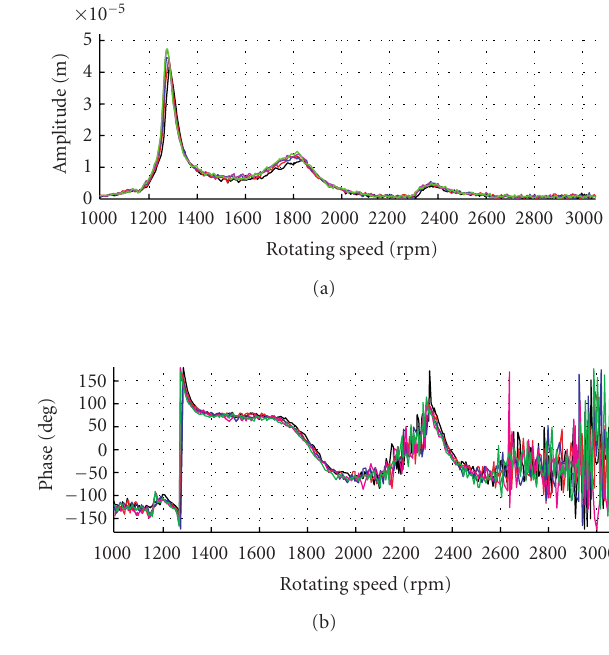
Figure 15: Unbalance responses of the 1st order during run-down for various bearing temperatures at the bearing support B1 (black line = 33 ◦ C; red line = 36 ◦ C; blue line = 40 ◦ C; magenta line = 42 ◦ C; green line = 44 ◦ C).